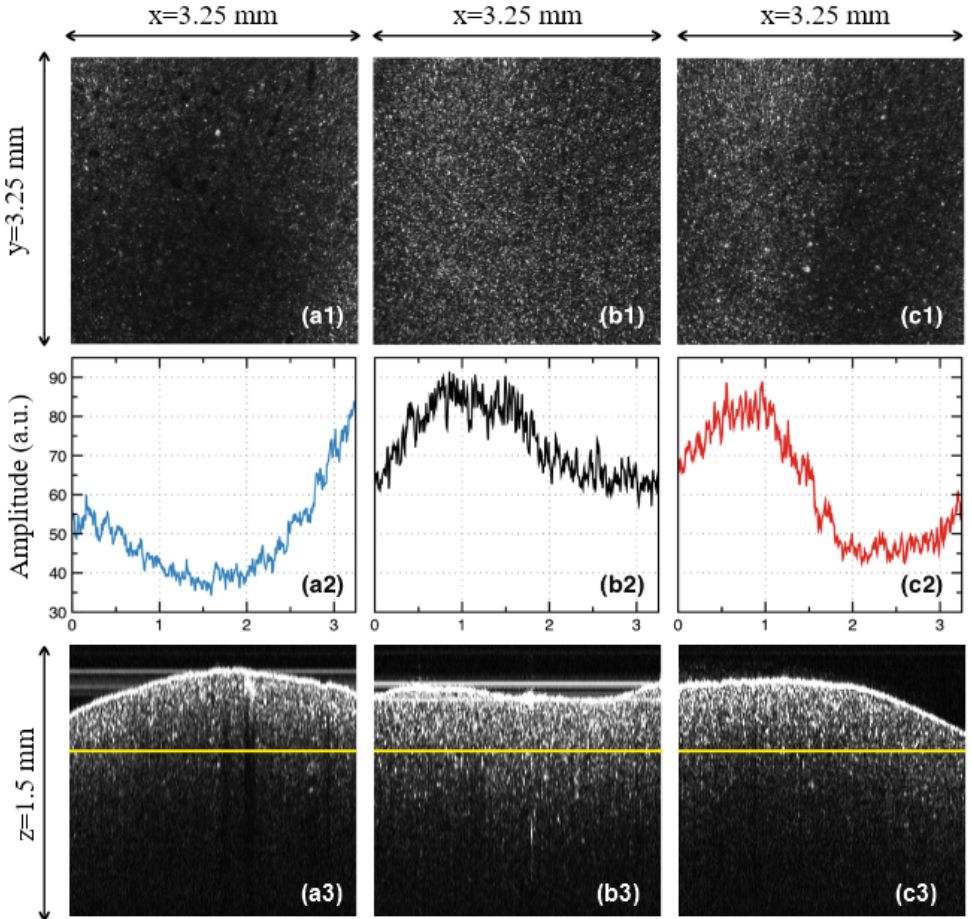
Figure 4. Examples of the OCT study of the samples pressed at different temperatures: ( a1–a3 ), Group L: sample pressed at 840 °C (50 °C below the normal temperature). ( b1–b3 ), Group N: sample pressed at the normal temperature of 890 °C, prescribed by the manufacturer. ( c1–c3 ), Group H: sample pressed at 940 °C (50 °C above the normal temperature). Steps of the analysis: Row ( 1 ), en face OCT image of the sample; Row ( 2 ), MATLAB processing of the en face OCT image; Row ( 3 ), B-scan (cross-section) OCT image—with the yellow line marking the sectioning plane used to obtain the en face OCT image (taken at a constant depth in the sample, considered from the zero OPD).